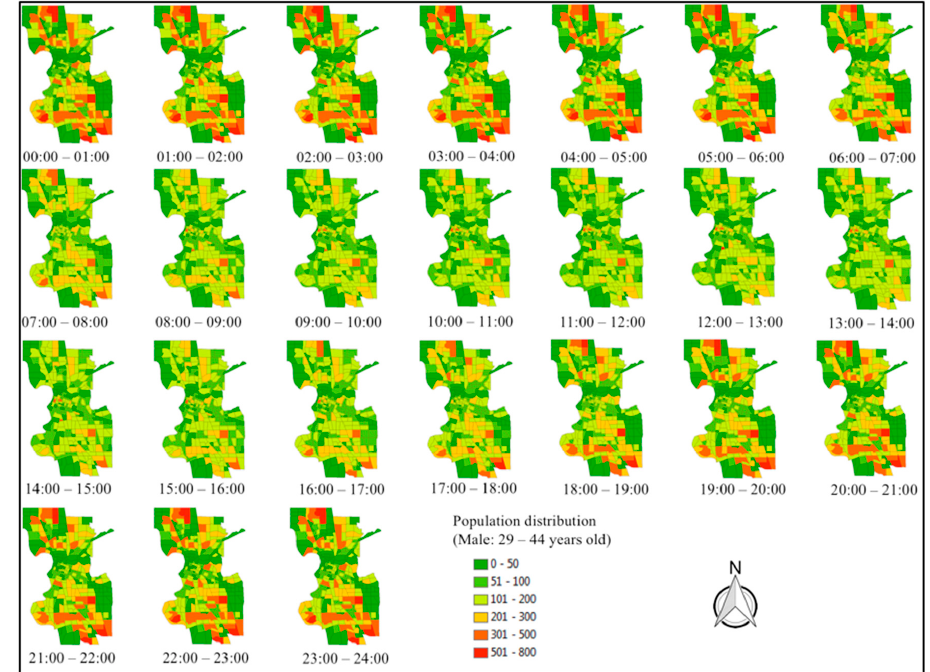
Figure 5. Hourly distribution of population (baseline 2012, male, 29–44 years old).